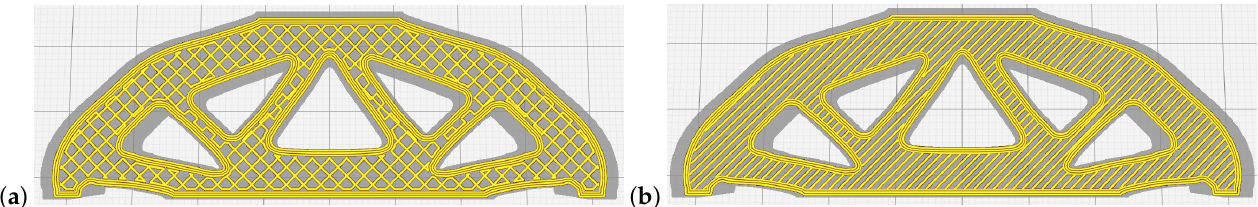
Figure 5. The infill patterns: ( a ) grid, ( b )